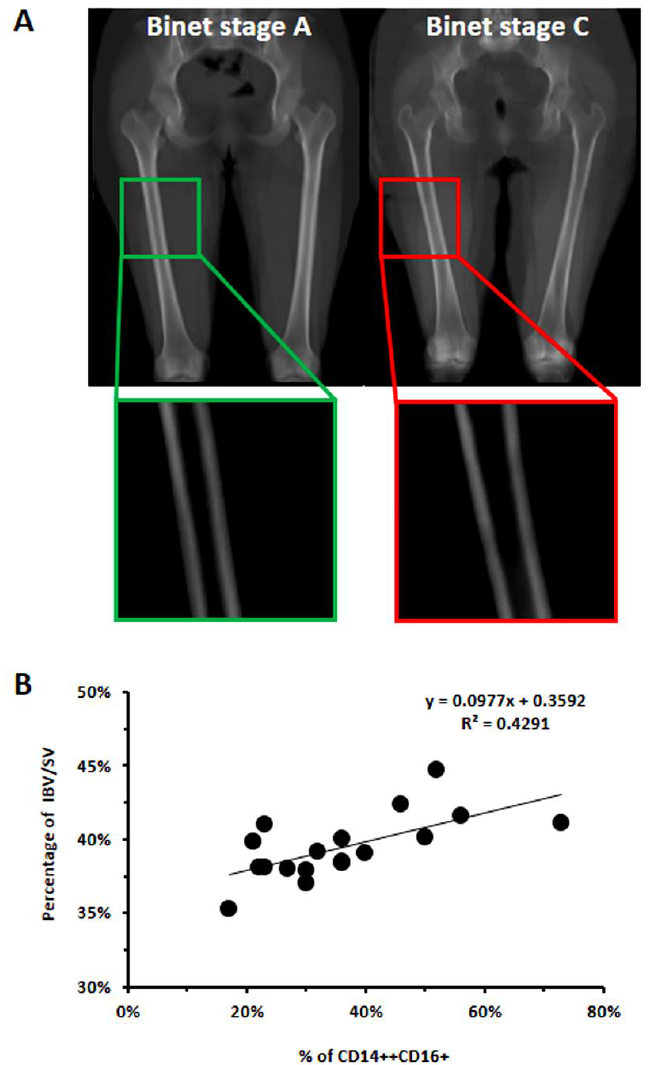
Figure 3. Representative radiograms of long bone shaft (femurs) in Binet stage A and C patients and correlation analysis of bone erosion levels and circulating CD14+CD16+ monocytes. ( A ) Enlarged X-ray scans document the thinning of the cortical bone and enlargement of the intra-bone volume of the femur diaphysis in a representative Binet C patient as compared to a Binet stage A one, among those included in this study. ( B ) The presented plot evidences a direct correlation between the percentage of circulating CD14++CD16+ (intermediate) monocytes and the index of bone erosion (IBV/SV